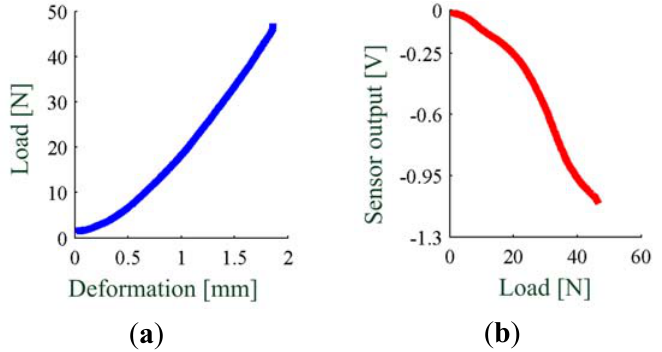
Figure 8. Characterization of the sensitive element of PSP2.0: ( a ) quasi-static force-to-deformation characterization; ( b ) quasi-static force-to-voltage curve (adapted from [39], ©2011 IEEE. Reprinted, with permission).